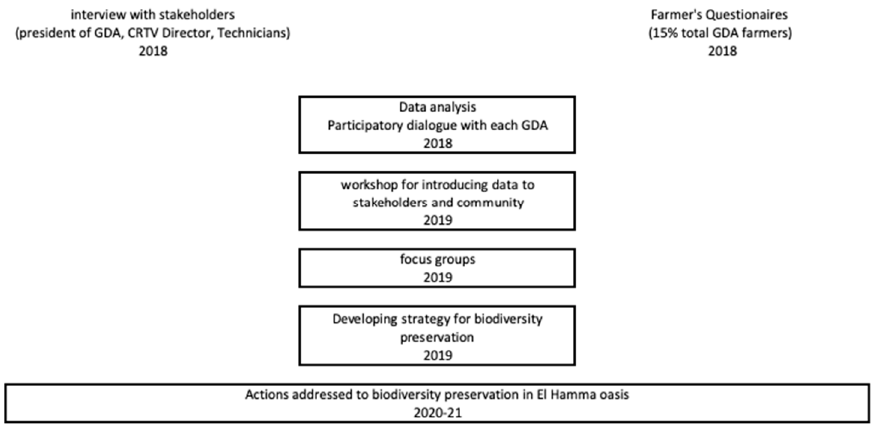
Figure 3. Flowchart of the process for acquisition and processing of information and development of a strategy for the preservation of biodiversity in the oasis of El Hamma.